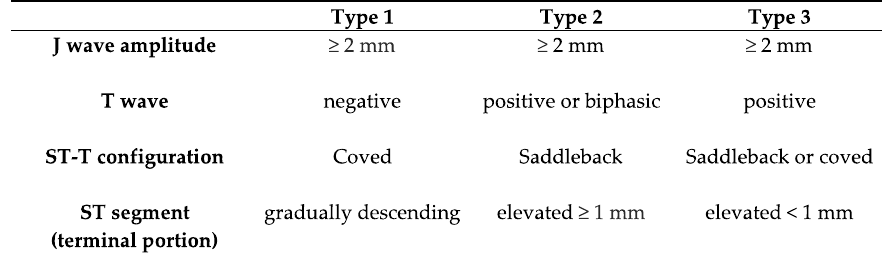
Figure 1. Brugada Syndrome—ECG pattern, inspired by Nishizaki et al., 2013 [16].